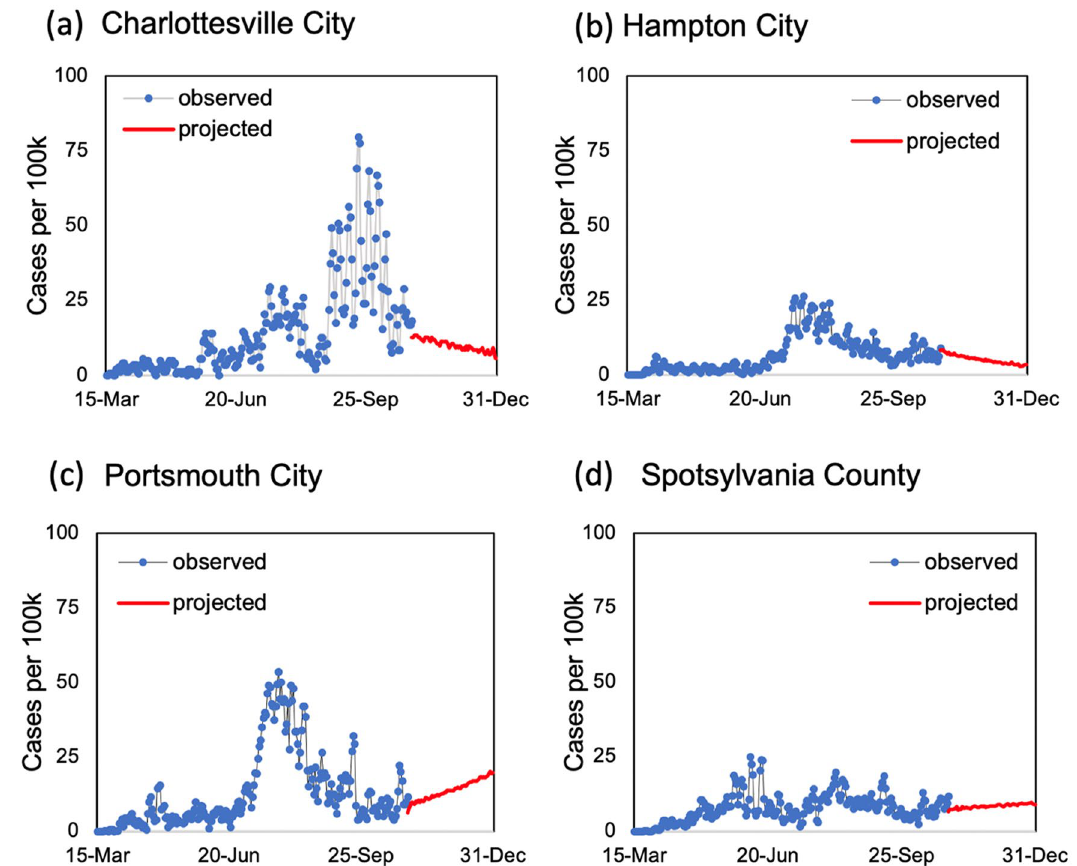
t values for four localities in Virginia: ( a ) Charlottesville City, ( b ) Hampton City, ( c ) Portsmouth City, and ( d ) Spotsylvania